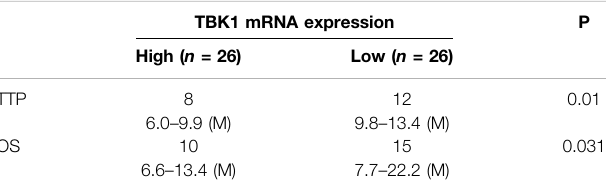
TABLE 3 | The endogenous TBK1 level associated with the clinical outcome of patients received sorafenib treatment. TBK1 mRNA expression